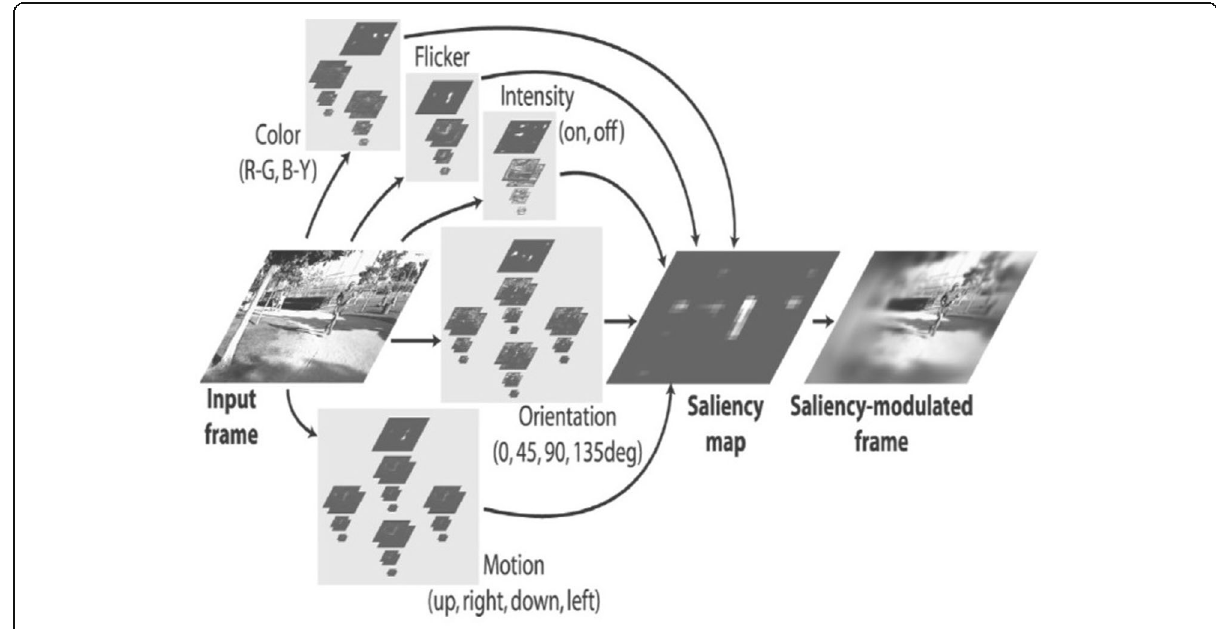
Fig. 1 iNVT (2014) biologically inspired computational model (Itti & Koch,